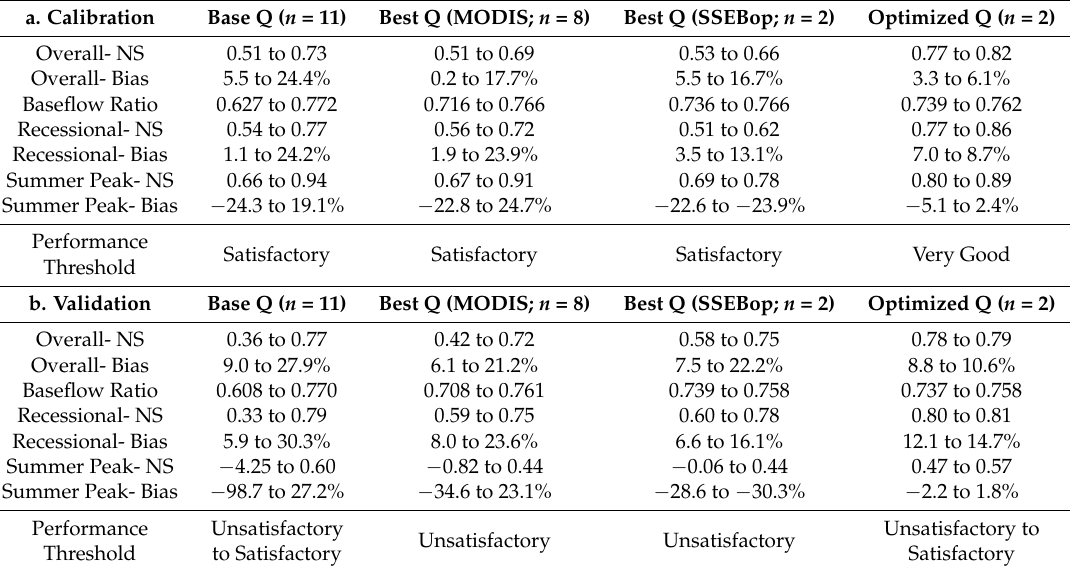
Table 5. Upper North Fork streamflow. ( a ) Calibration and ( b ) validation